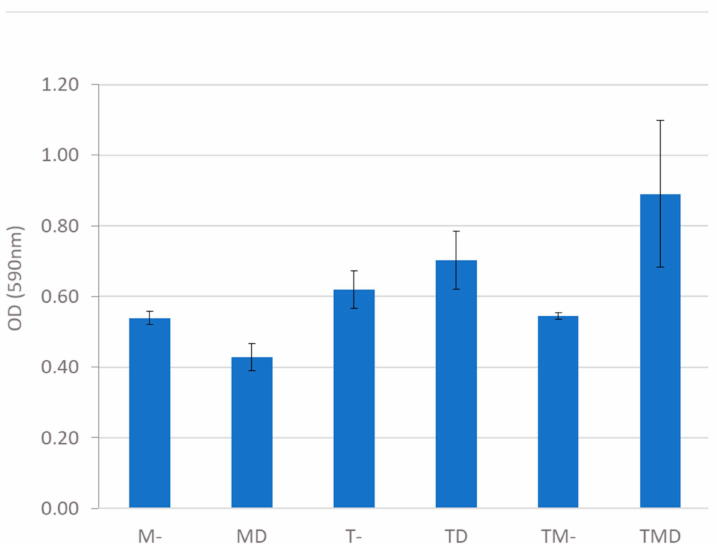
Figure 4. Quantification of biofilm density in MRS medium with starch, induced or not with dode- canol, incubated in a 24-well plate at 28 ◦ C and 200 rpm. T. amestolkiae (T), L. plantarum M9MG6-B2 (M), 100 mM dodecanol (D), without dodecanol (-).